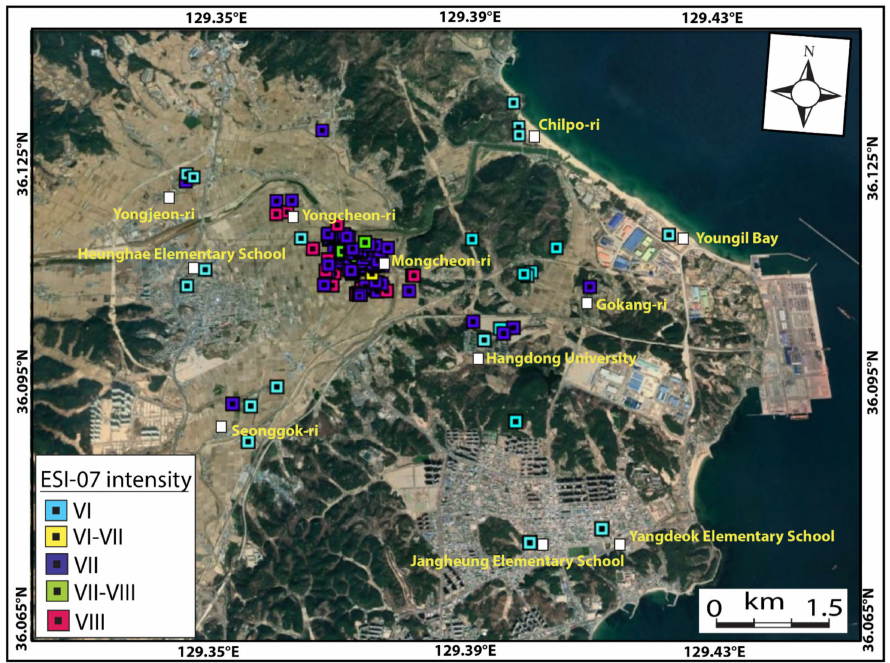
Figure 8. ESI (environmental seismic intensity) scale map for the epicentral region of the 2017 Pohang earthquake which shows ESI-07 scale value, which ranges from VI to VIII. Di ff erent colored squares show the di ff erent ESI-07 values derived from the recorded earthquake environmental e ff ects